Question: Provide a one-line summary of what is displayed.
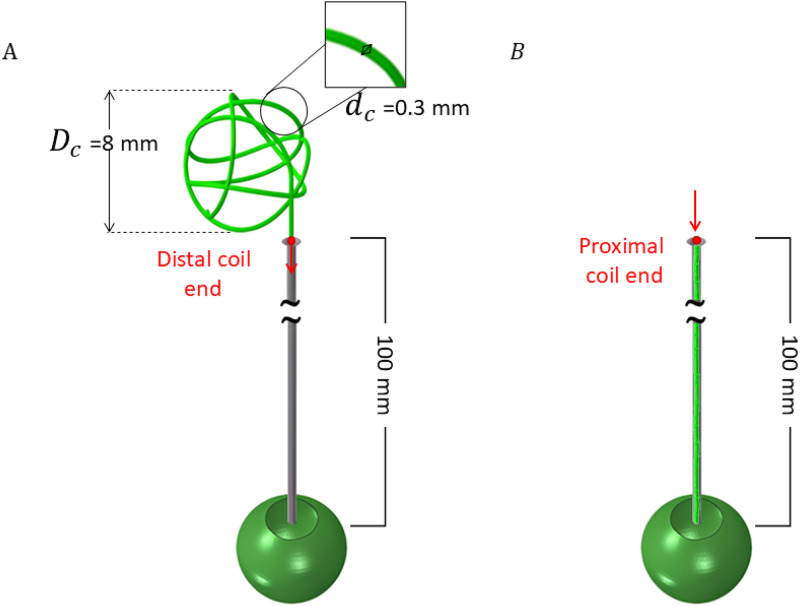
Answer: Setup for the finite element simulation of the endovascular coiling procedure. (a) Reference configuration of the model, showing the aneurysm sac, the catheter, and the coil generated at the free configuration. (b) Detail of the end of the packaging phase, in which the coil is fully inserted inside the rigid catheter, just before deployment. Red markers indicate the nodes where boundary conditions are imposed: at the distal coil end during the packaging phase (a) and at the proximal coil end during the deployment phase (b).